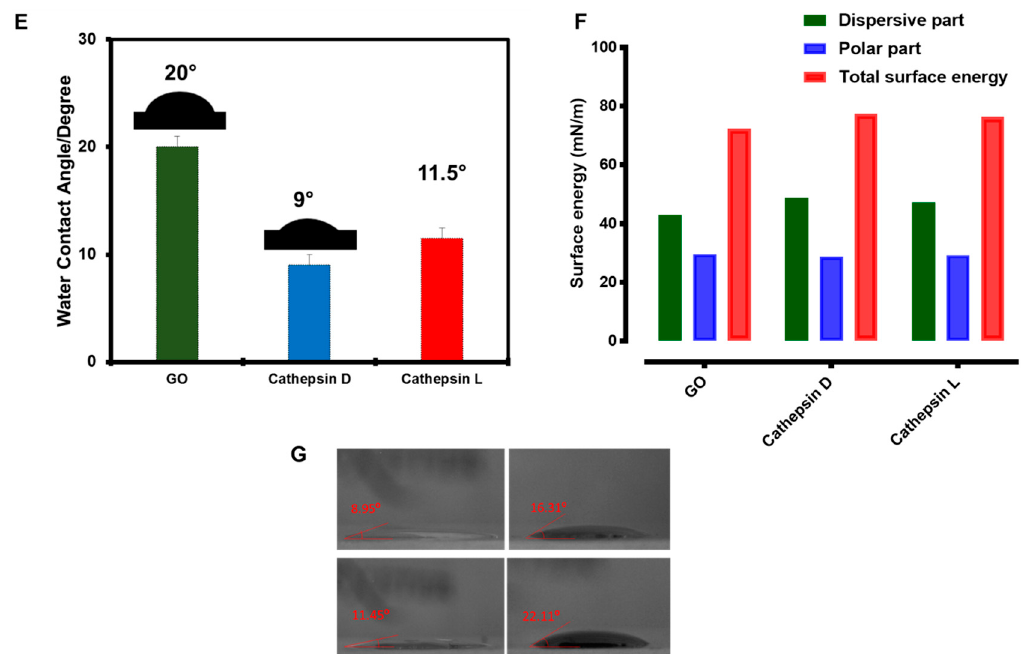
Figure 3. Characterization of cathepsin D (CathD) and cathepsin L (CathL). ( A ) CathD is highly active at pH 3.5–4 (optimum) and inactive at pH 7 and above. The CathD-specific fluorogenic substrate (10 µM) was incubated ± CathD (50 ng/mL) at the pH’s 3.6 and 7, and fluorescence intensity was measured at Ex/Em: 320/393 nm. Each data point represents n = 4 experiments. The horizontal bars represent SDs. ( B ) CathL is highly active in ionic buffer. A specific fluorogenic substrate ZVA (5 nM) was incubated ± CathL (50 ng/mL) at pH’s 5 and 7, and its fluorescence signals were measured at Ex/Em: 365/440 nm. Control wells contained substrate alone. The data are presented here as percentage of control (the relevant 100%). Each data point represents n = 4 experiments. The horizontal bars represent SDs. ( C ) FTIR spectra of CathD and CathL. ( D ) Raman spectra of CathD and CathL show bands at 1602 and 2024 cm − 1 . ( E ) Water contact angle profile of GO, CathD and CathL gives the values of 20°, 9° and 11.5°. ( F ) Surface energy profile of GO, CathD and CathL. ( G ) Representative image of wettability quantification as measured by water and diiodomethane contact angles of GO, CathD and CathL. The images were taken using a digital camera and analysed for contact angle measurements using the ImageJ processing program.